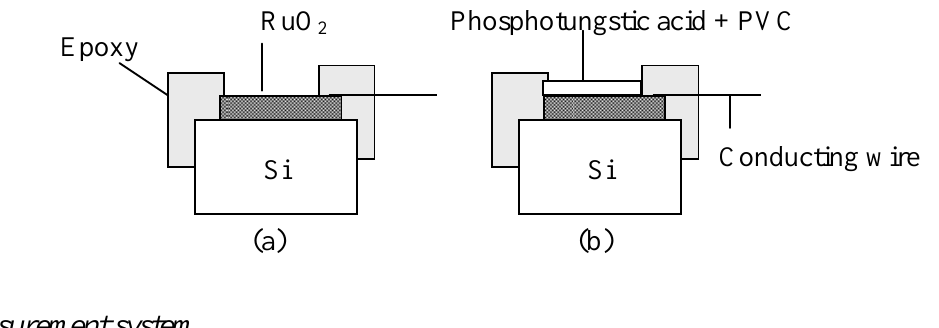
Figure 1. (a) Cross section of ruthenium dioxide membrane. (b) Cross section of procaine and berberine drug